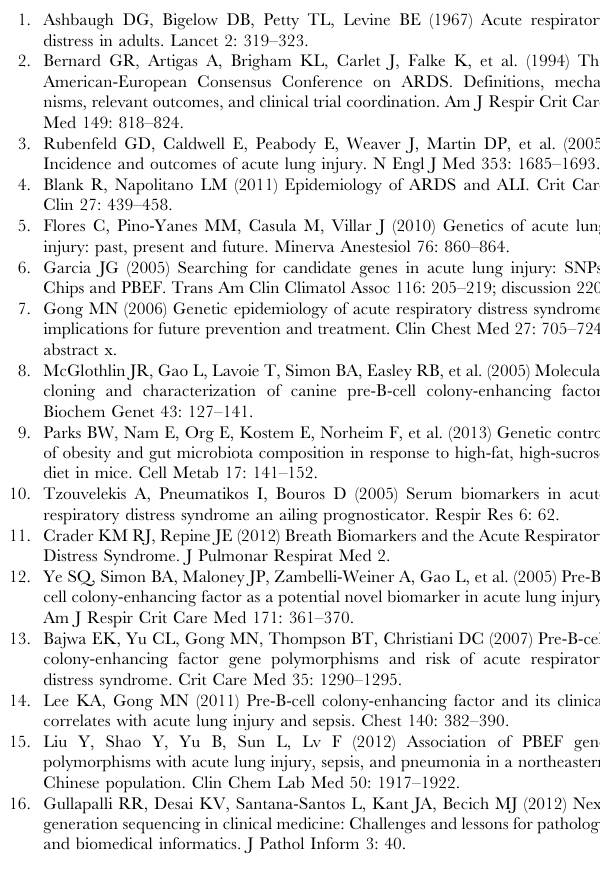
severity. Included in this table are the p-values of the logistic regression of ARDS patient genotype and APACHEII score by quartile. The APACHEII scores are split into quartiles and the 1 st and 4 th quartiles are used in a logistic regression against genotype using an additive model in the ARDS exome samples, TaqMan genotyped samples, and total ARDS samples. Regressions were also run on the stratified sub-populations of the ARDS patients. Associations were considered to be significant if P , 0.05. Table S5 A summary of the descriptive statistics for SNP rs78142040 in the exome sequenced ARDS, TaqMan genotyped ARDS patients, and total ARDS patients, where the controls are 1000 Genomes Project partici- pants. *, Chi-square tests were run on SNPs that were in both the controls and the cases; A, alternate allele; r, reference allele. Table S6 A summary of the descriptive statistics for SNP rs9605146 in the exome sequenced ARDS, TaqMan genotyped ARDS patients, and total ARDS patients, where the controls are 1000 Genomes Project partici- pants. *, Chi-square tests were run on SNPs that were in both the controls and the cases; A, alternate allele; r, reference allele. Table S7 A summary of the descriptive statistics for SNP rs3848719 in the exome sequenced ARDS, TaqMan genotyped ARDS patients, and total ARDS patients, where the controls are 1000 Genomes Project partici-